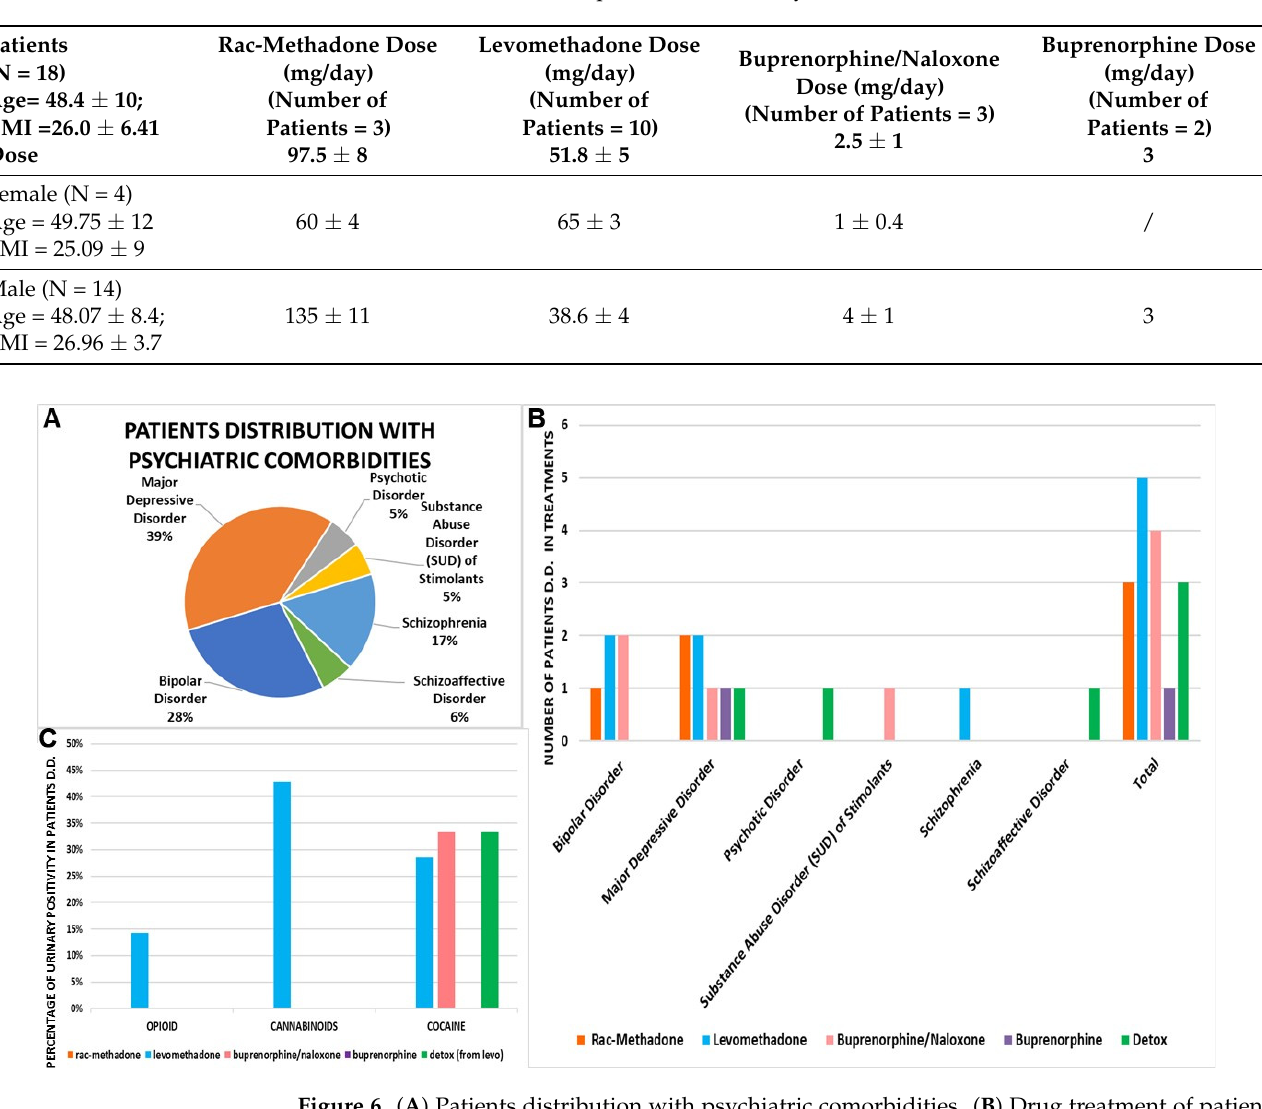
Table 8. Characteristics of the patients. BMI = body mass index.